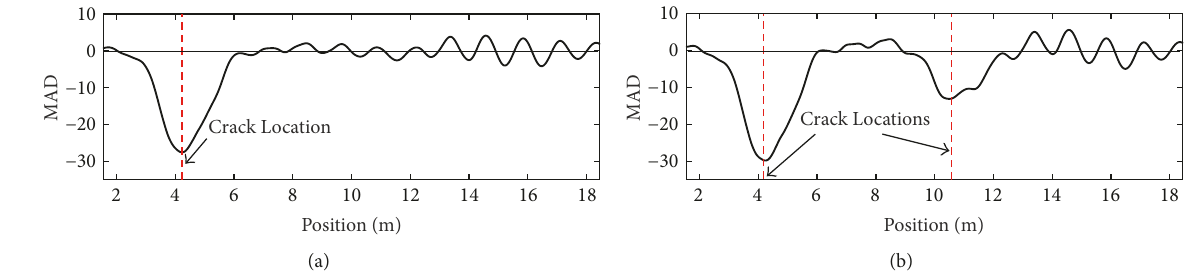
Figure 10: The second damage indicator: (a) the first damage case and (b) the second damage case.